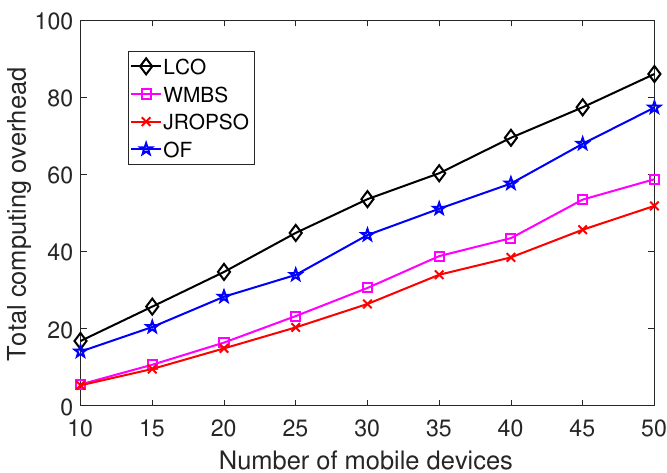
Figure 4. Comparison of the total computing overhead according to the number of MDs.